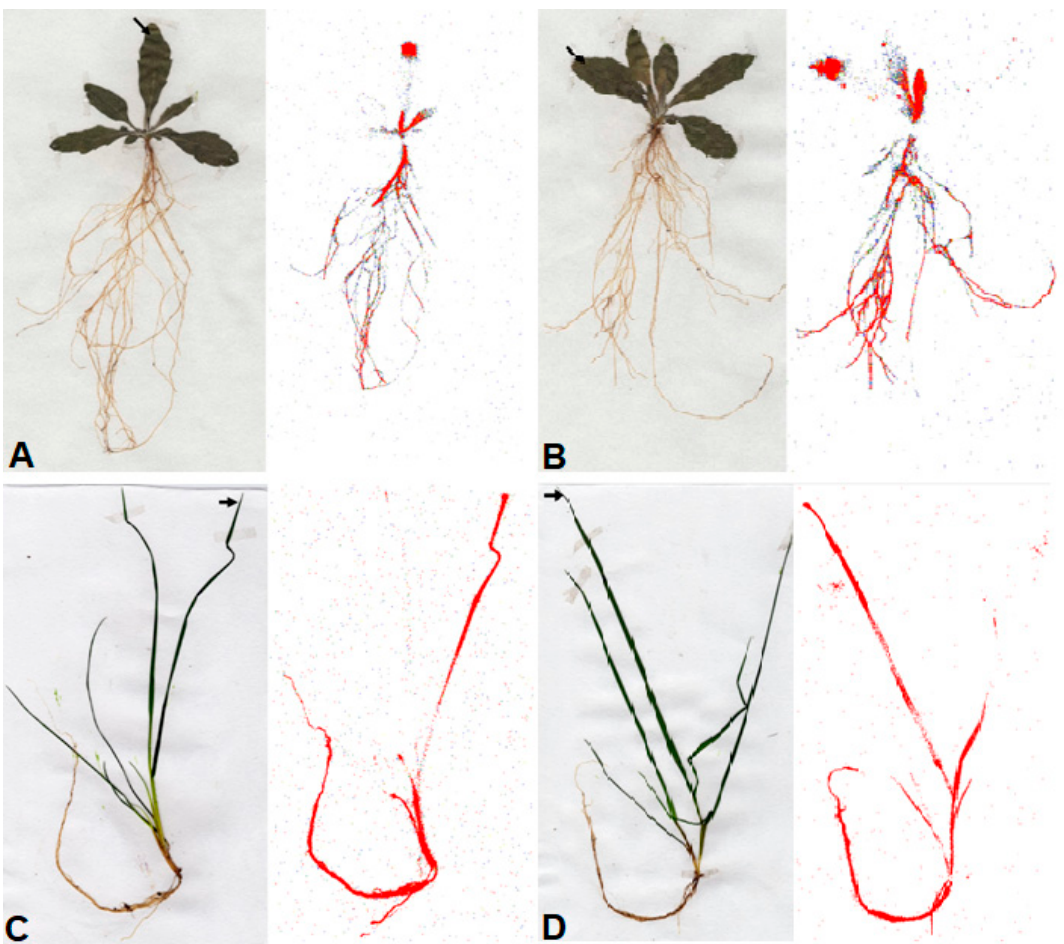
Figure 3. Digital image (plants on the left) and autoradiography (plants on the right) show the distribution of 14 C-glyphosate ( A and C ) and 14 C-glyphosate + Adj ( B and D ) within C. canadensis and L. rigidum populations, at 96 HAT.